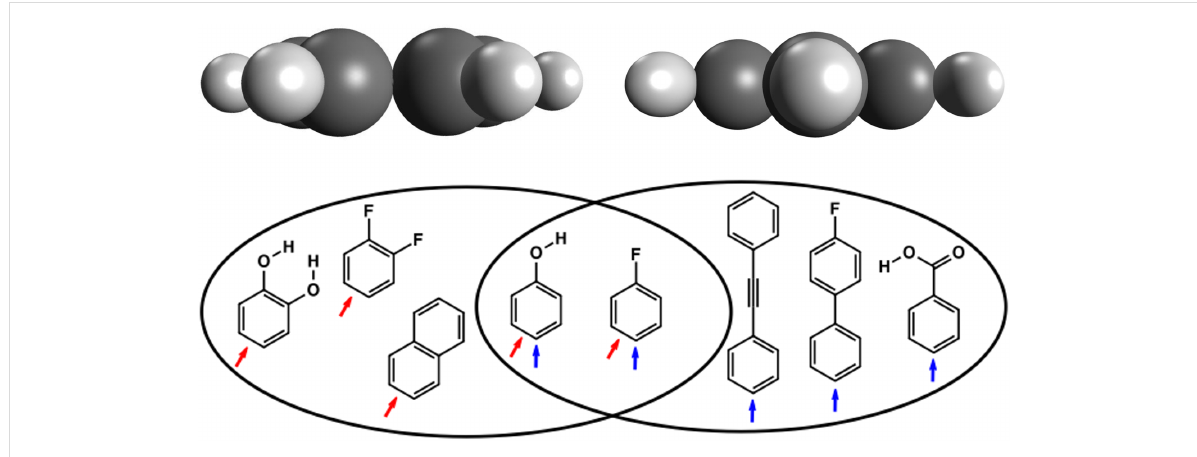
Figure 2: Multiple allocations of molecules to PI classes. Molecules that can be allocated to a group on the left: 1,2-dihydroxybenzene, 1,2-difluoro- benzene, naphthalene. Molecules that can be allocated to a group on the right: diphenylacetylene, 4-fluorobiphenyl, benzoic acid. Molecules that can be allocated to both groups: benzene (not shown), phenol, fluorobenzene (the arrows in red and blue indicate the two different view points of the